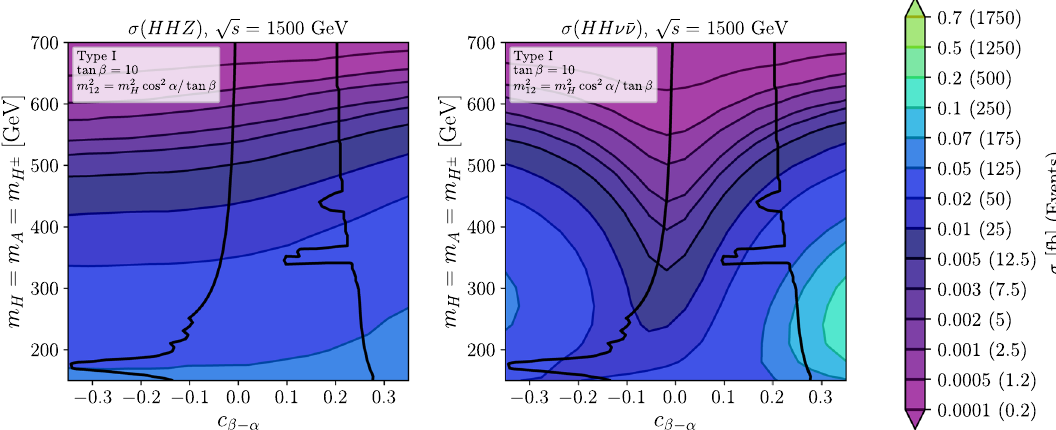
√ s = 1500 GeV for our benchmark plane 3. The total allowed regions is